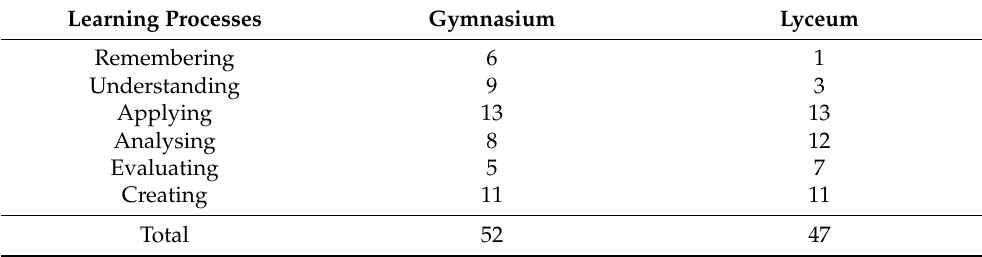
Table 4. Taxonomy of the expected learning outcomes in learning processes.